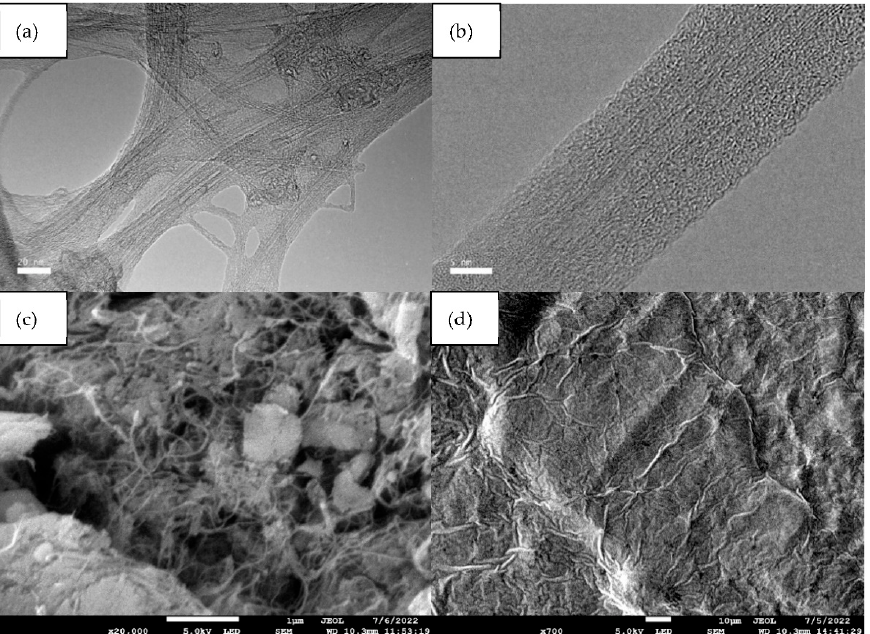
Figure 1. Surface morphology of CNT: ( a , b ) TEM images of CNT, ( c ) FESEM image of CNT powder, ( d ) FESEM image of CNT ‐ chitin film.